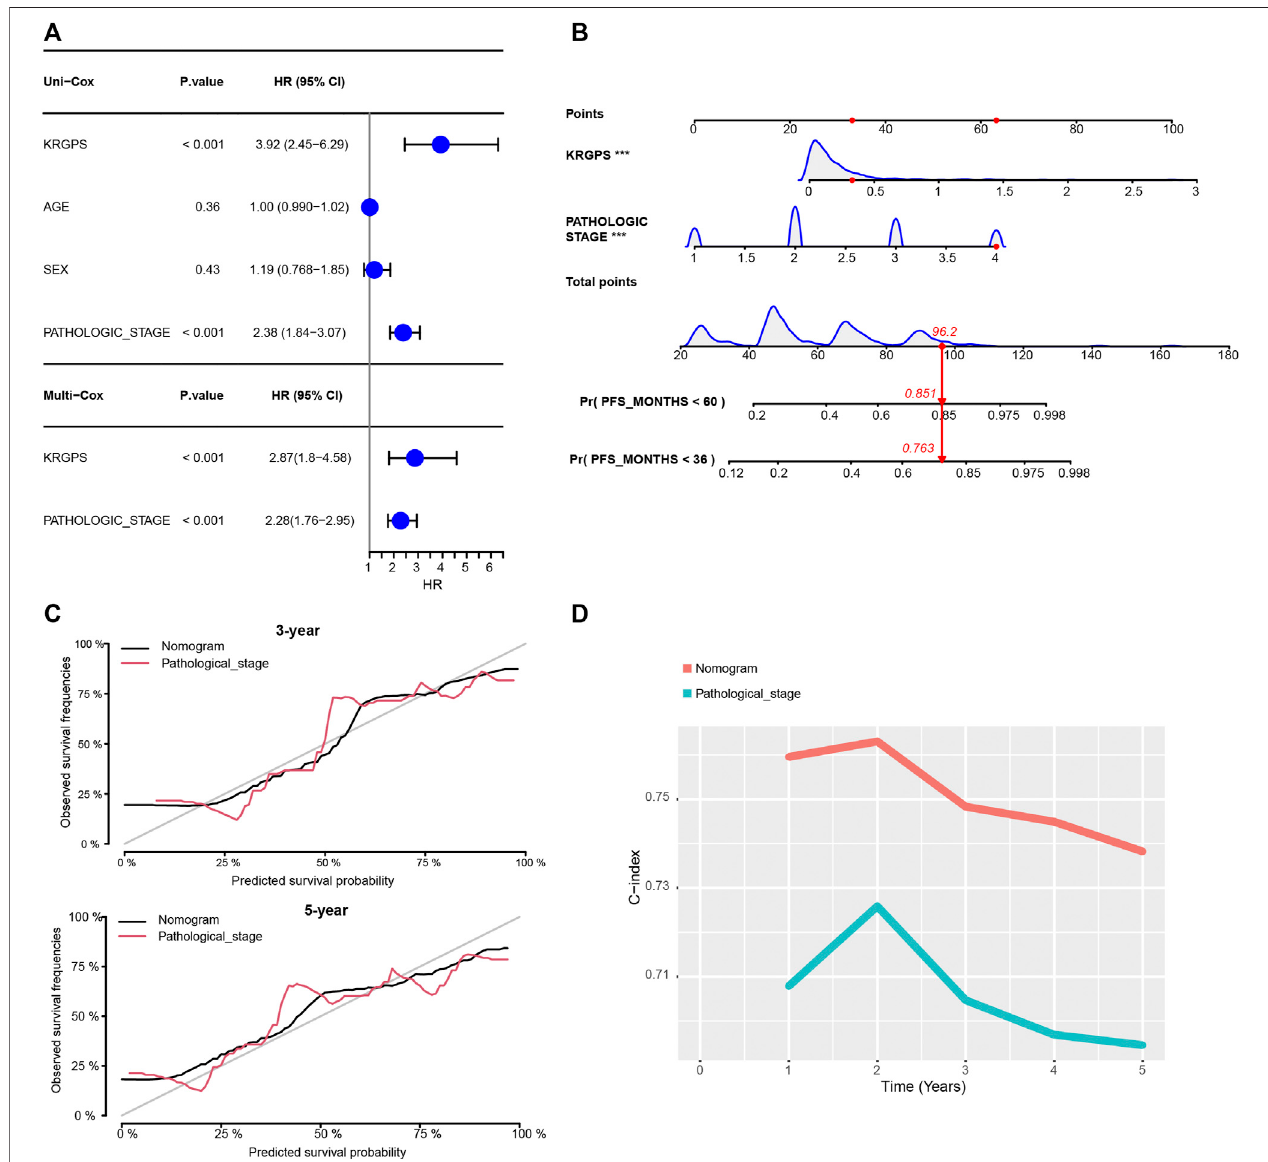
FIGURE 4 | Construction of the nomogram. (A) Univariate and multivariate Cox regression of clinical signatures and KRGPS. (B) The nomogram was constructed based on the independent prognostic factors evaluated by multivariate Cox regression (C) The calibration plots for the internal validation of the nomogram predicting 3- years and 5-years PFS. (D) C-index of the nomogram and pathological stage predicting PFS in different years.